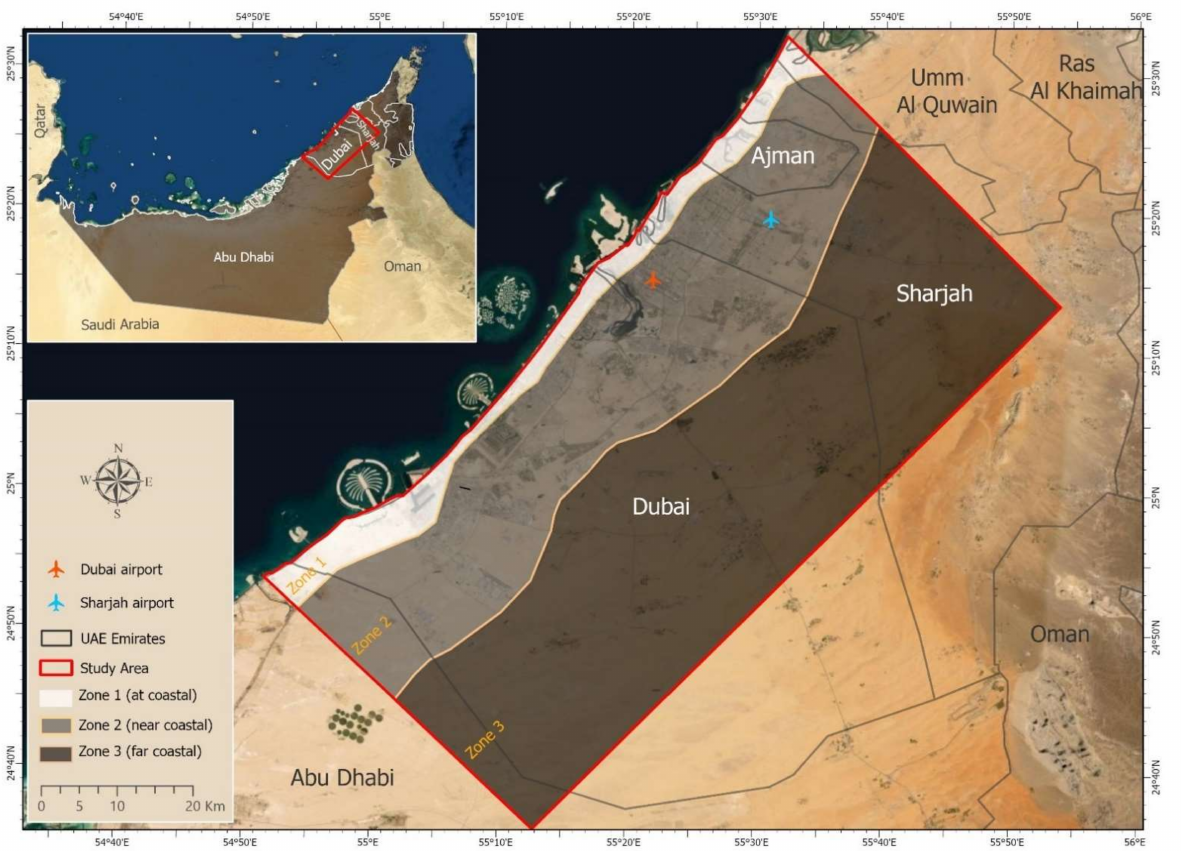
Figure 2. Study area map, including Dubai, Sharjah, and Ajman in the